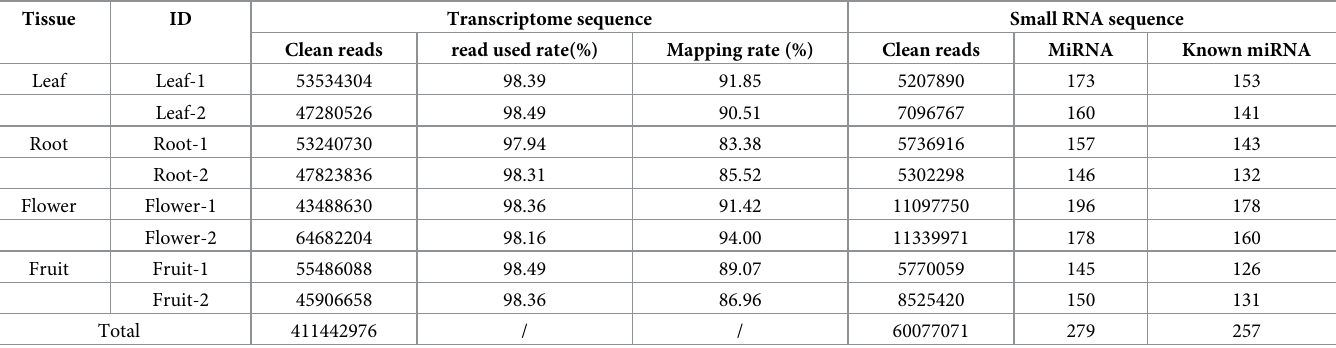
Table 1. Summarization of transcriptome and small RNA sequence data.